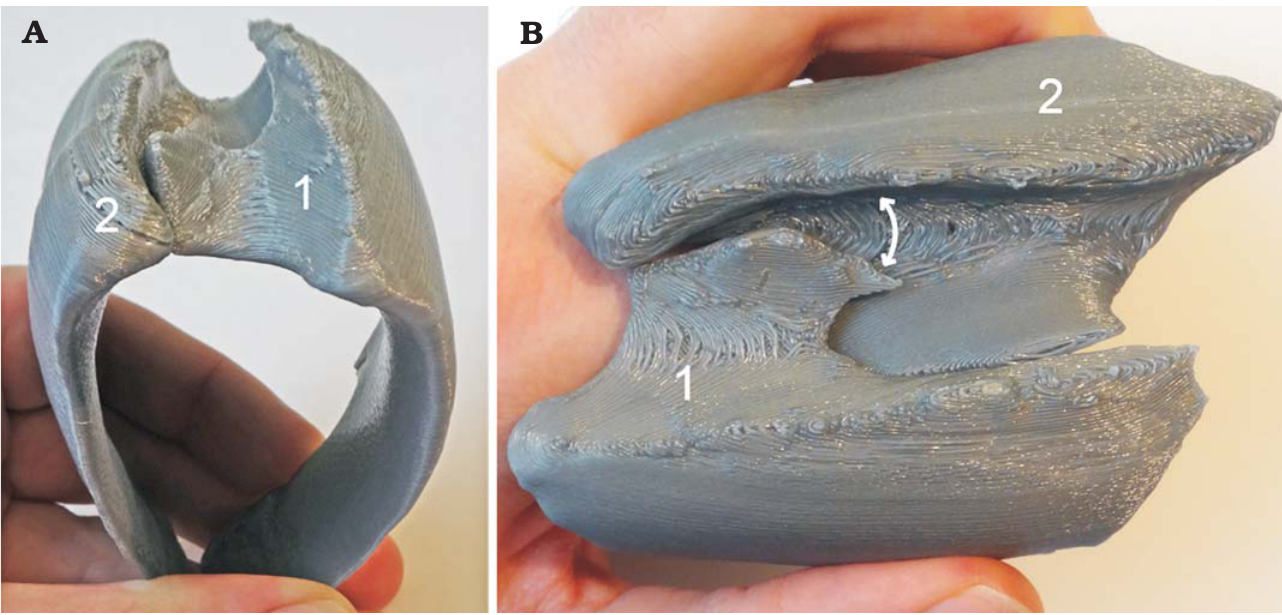
Fig. 6. View of a pair of 3D-prints of articulated right (1) and left (2) sclerites from obliquely posterior ( A ) and dorsal ( B ) views. Note the perfect fit of the sclerites. Within the hinge of sclerite 1 in B, the indentation on the right of the hinge flange is an artefact from tresholding (probably, the shell was too thin in that place). Sclerites 1 and 2 were enlarged 25 times (for original dimensions see Fig. 4).